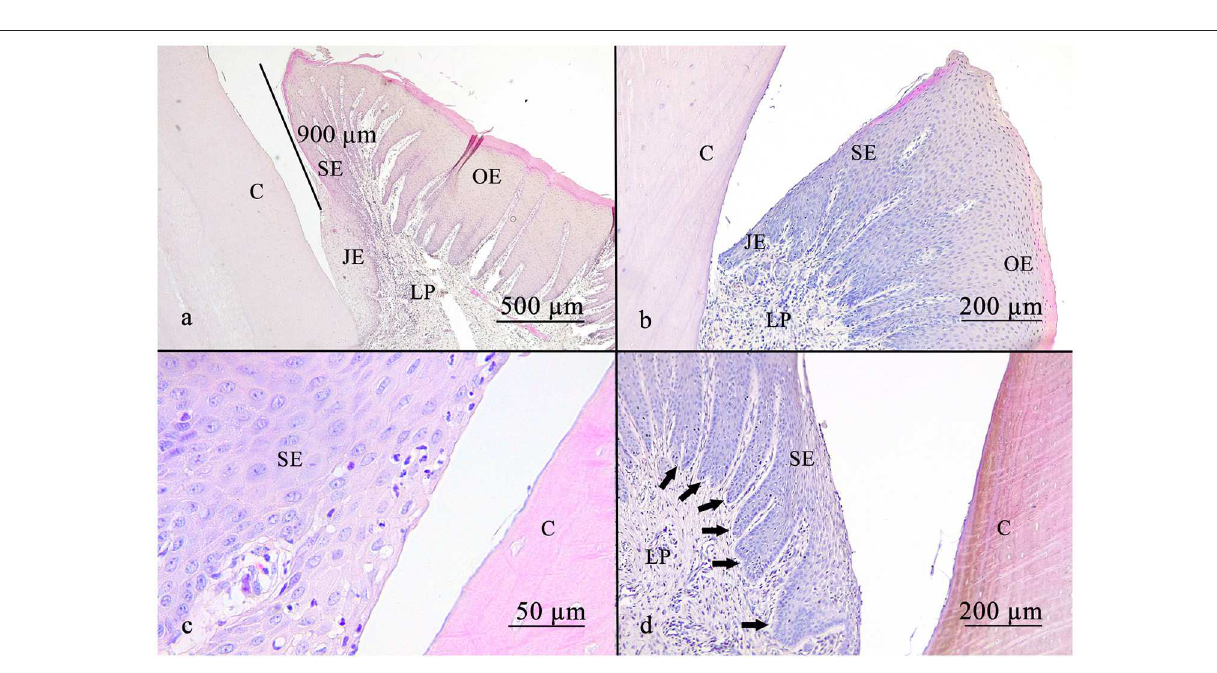
recorded and in 15.8% (3/19), the epithelium showed a non- keratinized stratified squamous epithelium. The epithelium consisted of more than 10 cell-layers in the region of the occlusal tip of the interdental gingiva. In the mesial and distal